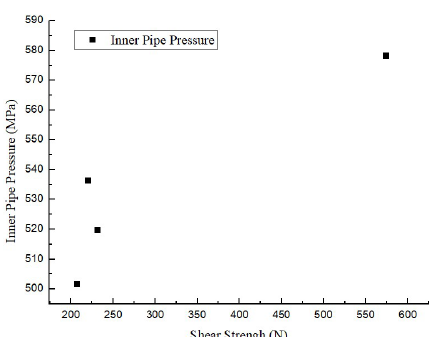
Figure 14. Shear strength according to the type of grinding condi- tion.